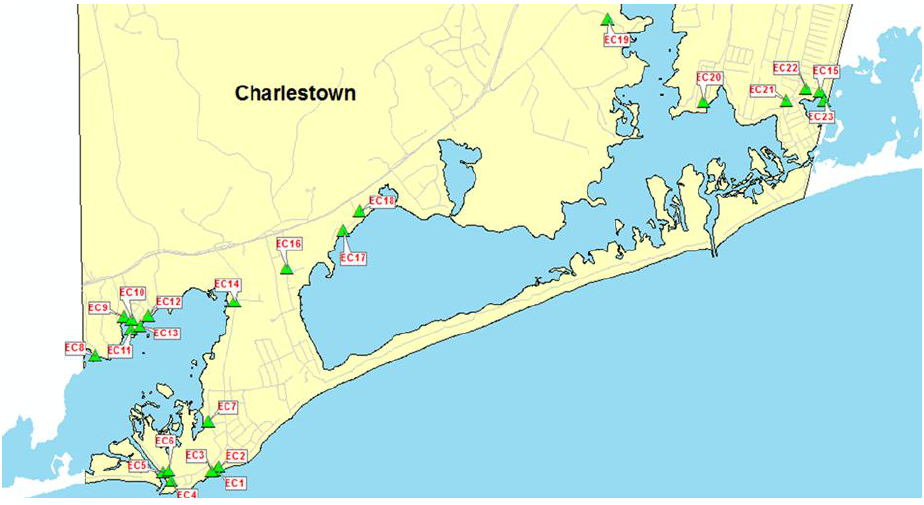
Figure 7. Location of elevation certificates for Charlestown, RI study area provided by the Town of Charlestown, RI.